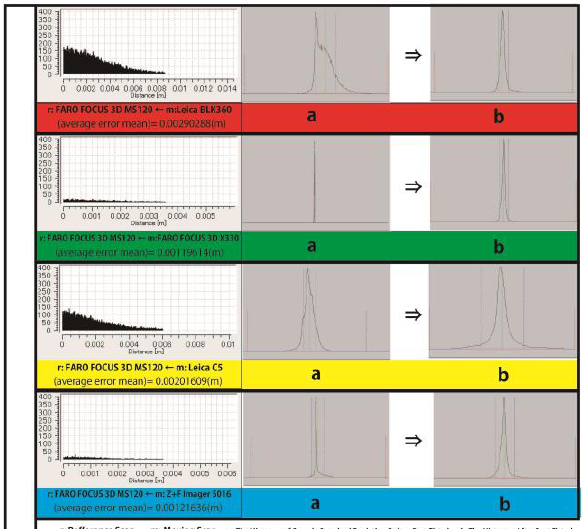
Figure 6: The Results of Alignments (Refference:FARO Focus 3D MS120), (JRC 3D Recnstructor and IMAlign were used)